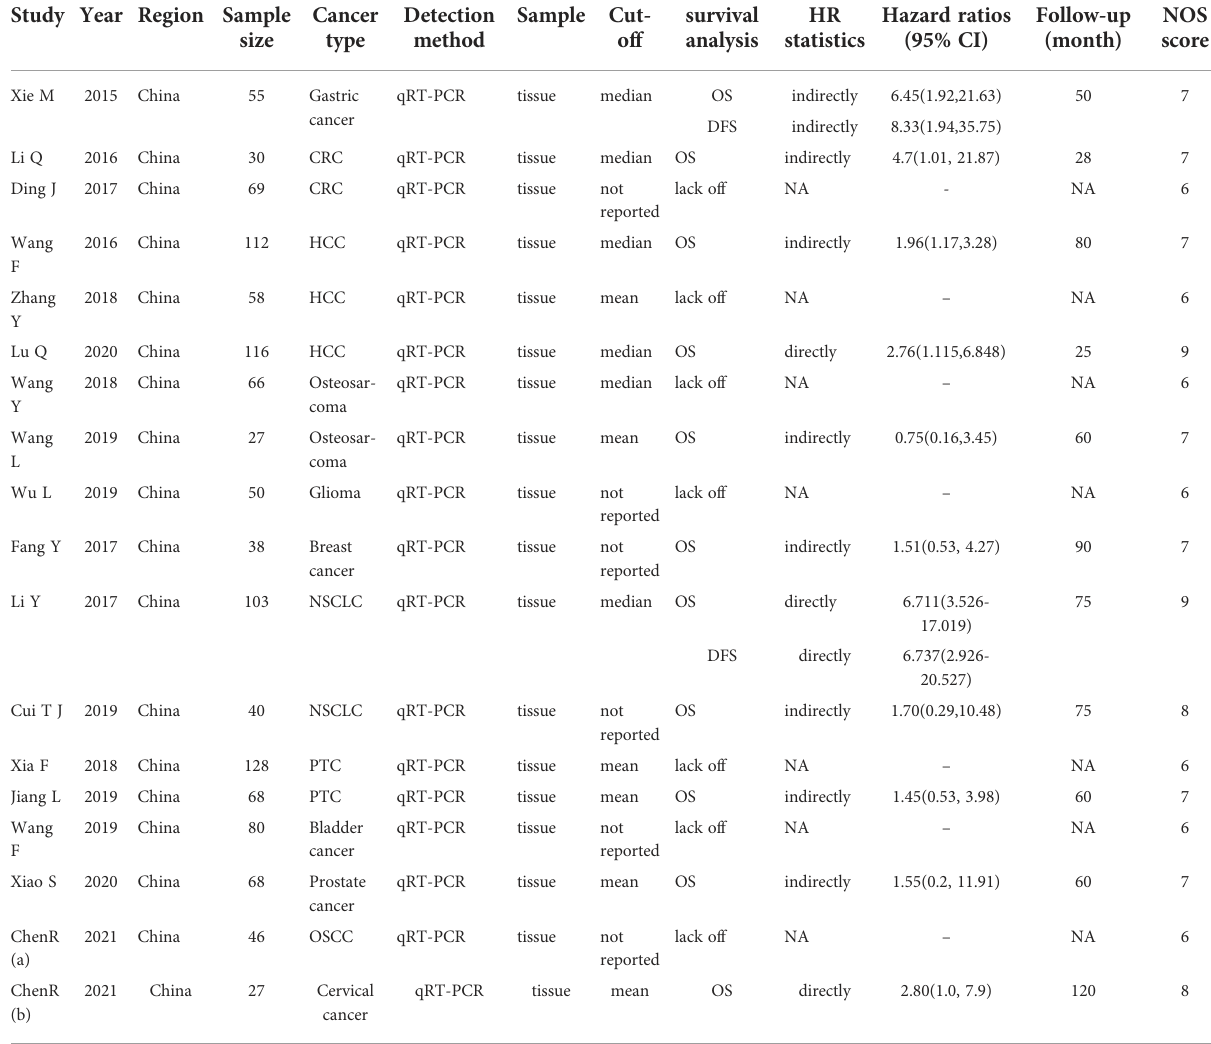
TABLE 1 Basic features of the publications included in this meta-analysis